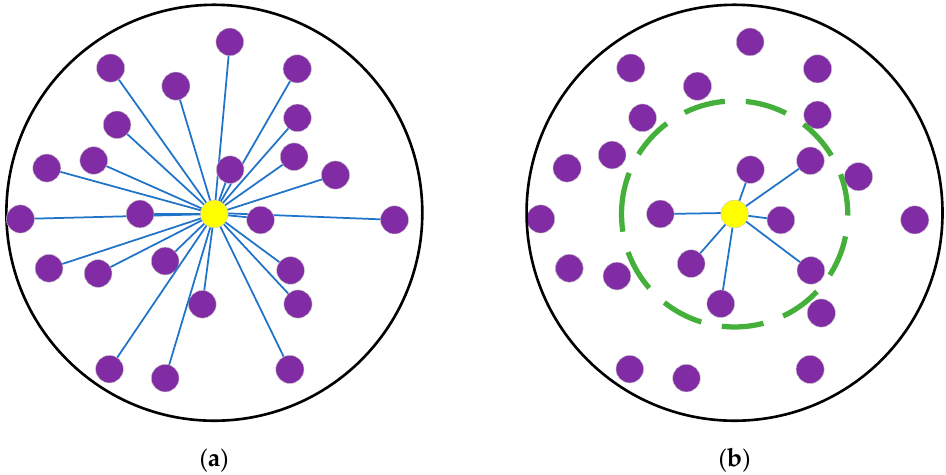
Figure 2. Comparison of fixed-distance interaction structure and topological interaction structure. ( a ) the fixed-distance interaction structure; ( b ) the topological interaction structure.